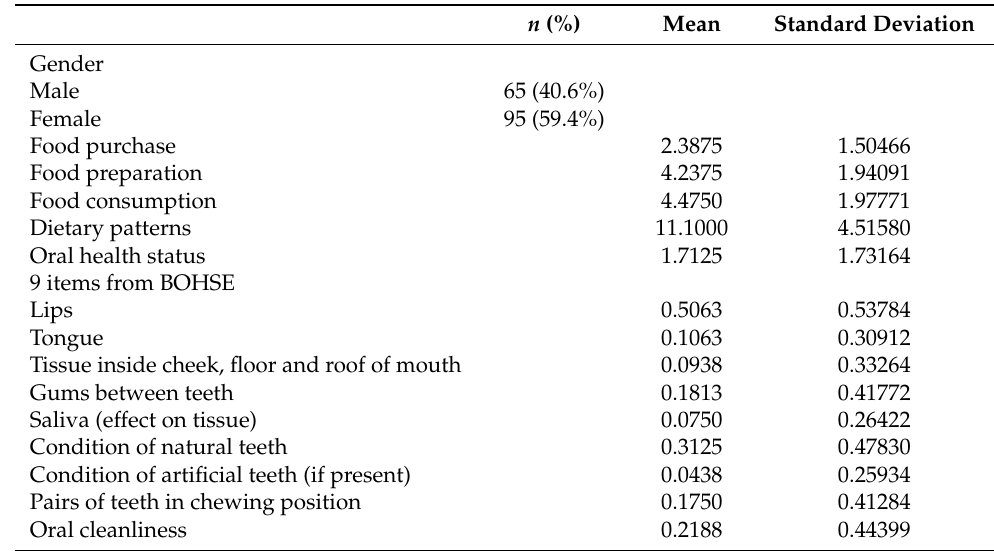
Table 1. Summary measures for demographic, food purchase, food preparation, food consumption, dietary patterns and oral health status.